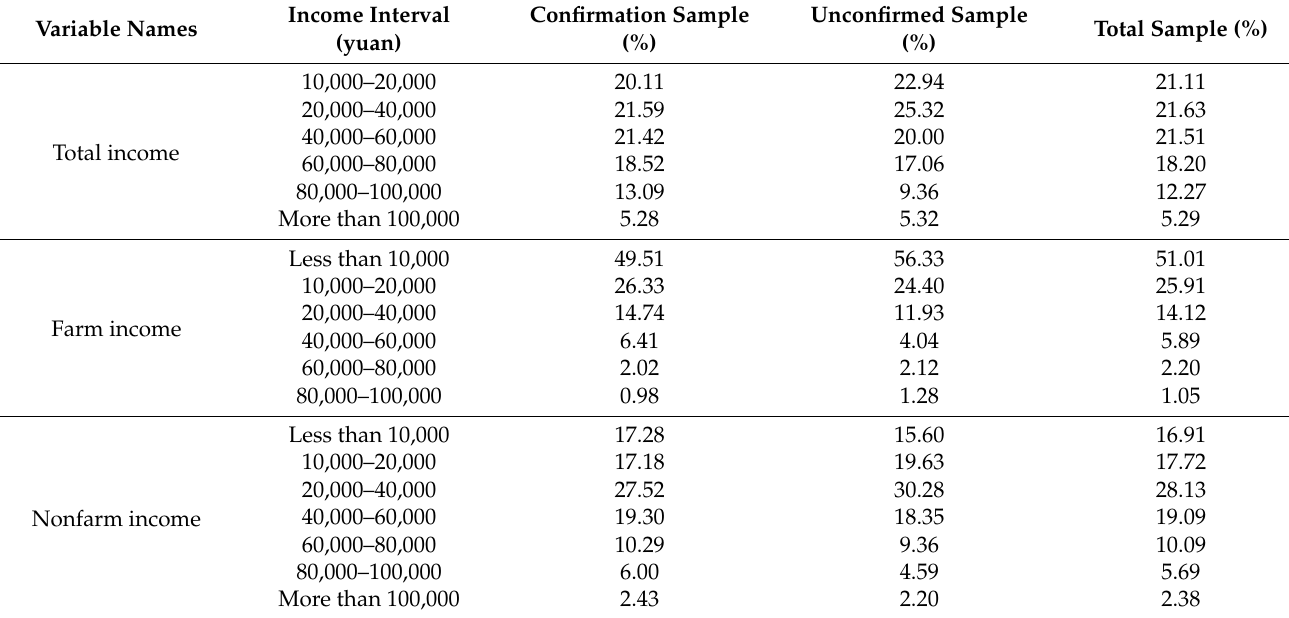
Table 2. Distribution of farmers’